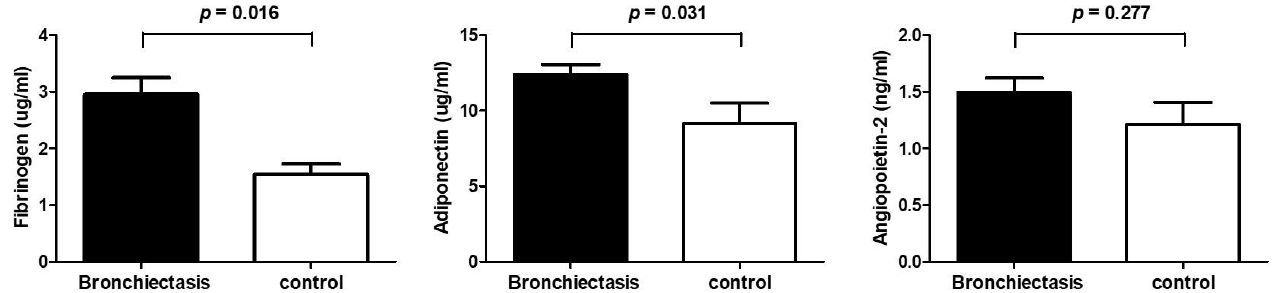
Figure 1. Comparison of fibrinogen, adiponectin, and angiopoietin-2 levels between patients with bronchiectasis and healthy controls.